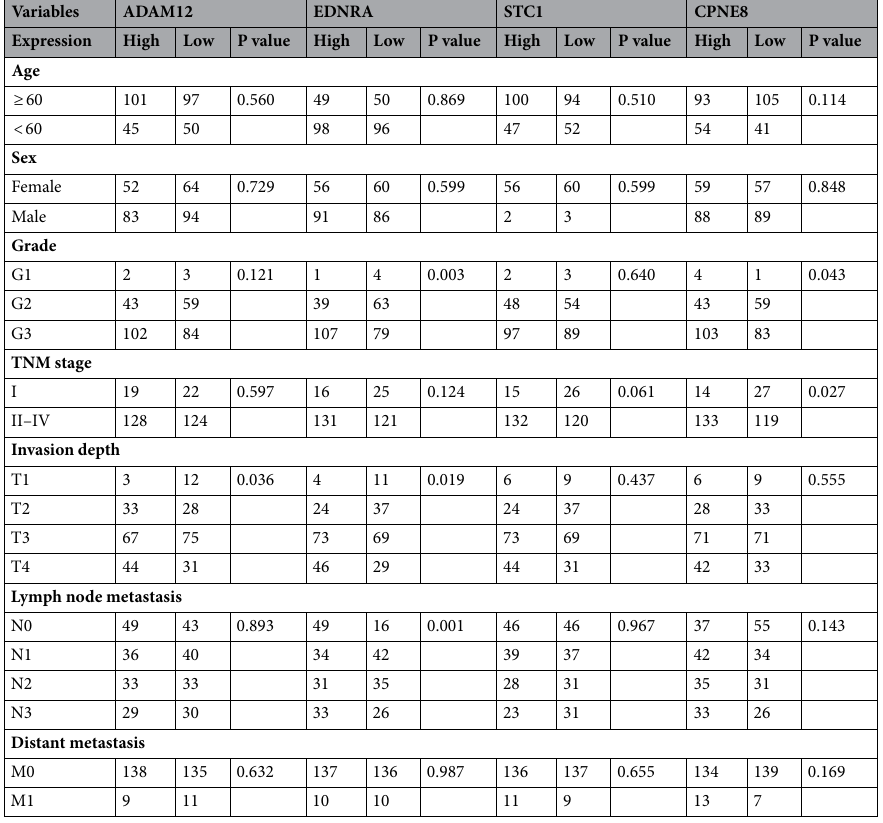
expression level of CPNE8 was significantly associated with grade (P = 0.043) and TNM stage (P = 0.027) in GC patients. However, the expression of STC1 was not associated with any clinicopathological features. Association of miR‑30c‑5p target genes with overall survival and prognosis of gastric cancer and assessment of diagnostic value. The prognostic value of miR-30c-5p target gene expression levels in GC was analyzed using the GEPIA or Kaplan–Meier plotter online analysis website. As shown in Supplemen- tary Fig. S3 and Supplementary Fig. S4, the miR-30c-5p target gene high expression level group of miR-30c-5p target genes were predict poor prognosis by using the GEPIA or Kaplan–Meier plotter online tools. In addition, univariate Cox regression analysis revealed the role of miR-30c-5p target genes in the prognosis of gastric cancer. The results showed that age (P = 0.0072), TNM stage (P = 0.0002), lymph node metastasis (P = 0.0012), ADAM12 expression (P = 0.0052), EDNRA expression (P = 0.0125), STC1 expression (P = 0.0086), and CPNE8 expression (P = 0.00081) were significantly related with the prognostic of GC patients (Table 2). Overall, the miR-30c-5p target gene was an unfavorable prognostic factor marker. As shown in Supplementary Fig. S5, the AUC values of ADAM12, EDNRA, STC1, and CPNE8 were 0.963 (95% CI = 0.973–0.990), 0.717 (95% CI = 0.634–0.800),0.782 (95% CI = 0.705–0.859), and 0.585 (95% CI = 0.490–0.680), respectively. It suggested that ADAM12, EDNRA, and STC1 had high value in the diagnosis of gastric cancer. Gene set enrichment analysis of miR‑30c‑5p target genes. GSEA_4.1.0 enrichment software 32 was used for analysis the potential molecular mechanism of the miR-30c-5p target genes in gastric carcinogenesis, and the enrichment pathway was set to be significant for nominal (NOM) p < 0.05 and false discovery rate (FDR) q < 0.05. In the high expression group of miR-30c-5p target genes , the enriched terms involved in the signifi- cant up-regulation of cell adhesion and tumorigenesis were "ECM receptor interaction", "focal adhesion", "JAK signaling pathway", and "MAPK signaling pathway". The detail information was listed in Supplementary Spread- sheets 4 and Supplementary Fig. S6. Association between the miR‑30c‑5p target genes and tumor infiltrating immune cells in gas‑ tric cancer. In order to explore the correlation between the expressions of miR-30c-5p target genes and tumor-infiltrating immune cells (TIC) abundance, CIBERSORT algorithm 33 was used to screen the propor- tion of immune cell subsets. TA total of 375 GC patients with adjust P < 0.05 were selected for the following analysis (Supplementary Fig. S7A), the correlation of 22 tumor-infiltrating immune cells analysis demonstrated